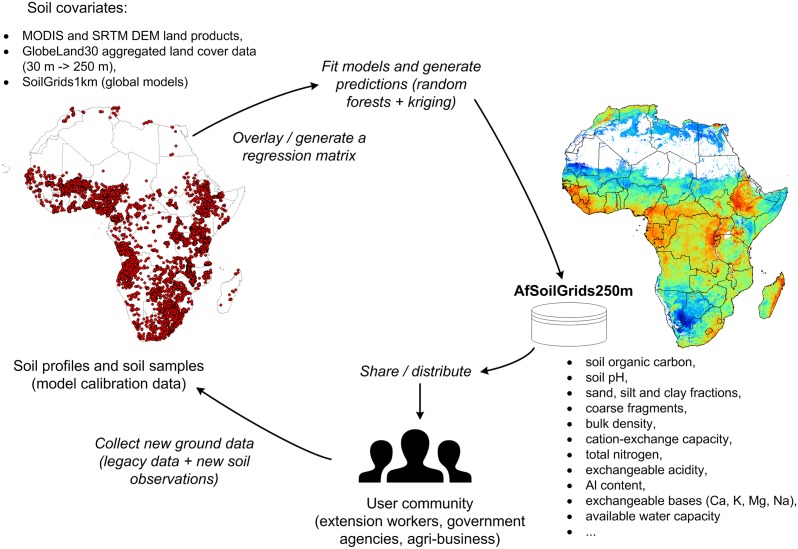
Spatial prediction scheme used to produce AfSoilGrids250m data.Spatial predictions in the case of an automated soil mapping system can be continuously updated by adding new soil field observations and new covariates.